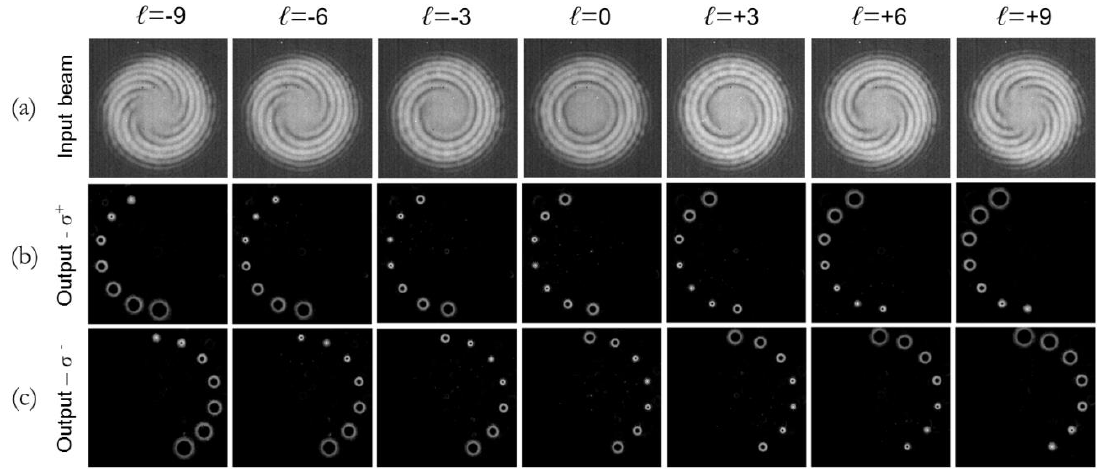
Figure 6. ( a ) Interference patterns of the OAM beams exploited for the sorter characterization. The number and twist handedness of the spirals is indicative of the carried OAM. Output of the fabricated OAM for input right-handed ( b ) and left-handed ( c ) circular polarization states. As expected, the far-field bright spot position is in accordance with the far-field channel constellation in Figure 2b.